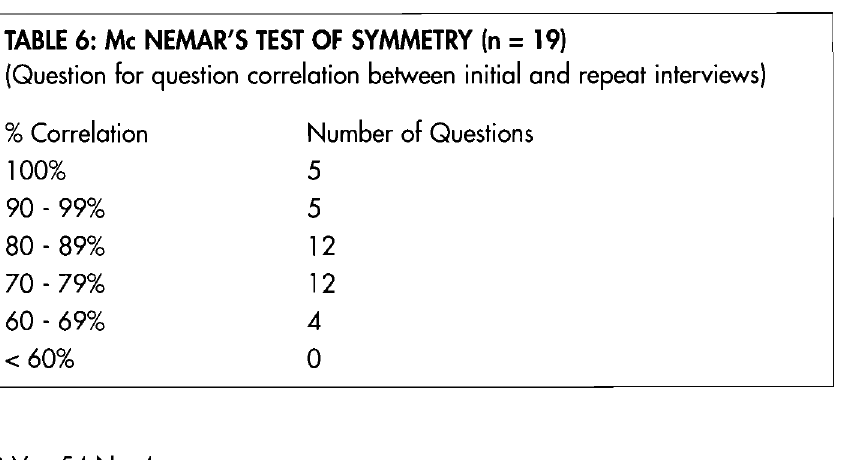
TABLE 6: Me NEMAR'S TEST OF SYMMETRY (n =